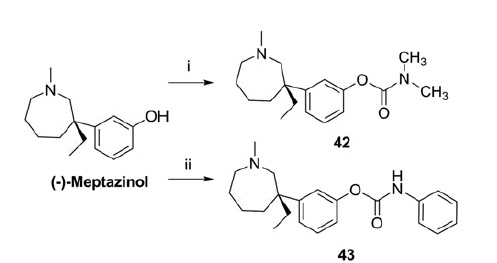
Synthesis of 42 and 43.aaReagents and conditions: (i) Me2NCOCl, NaH, dry THF, 0 °C to rt, 2 h, 100%; (ii) PhNCO, Na, dry Et2O, rt, 3 h, 72%